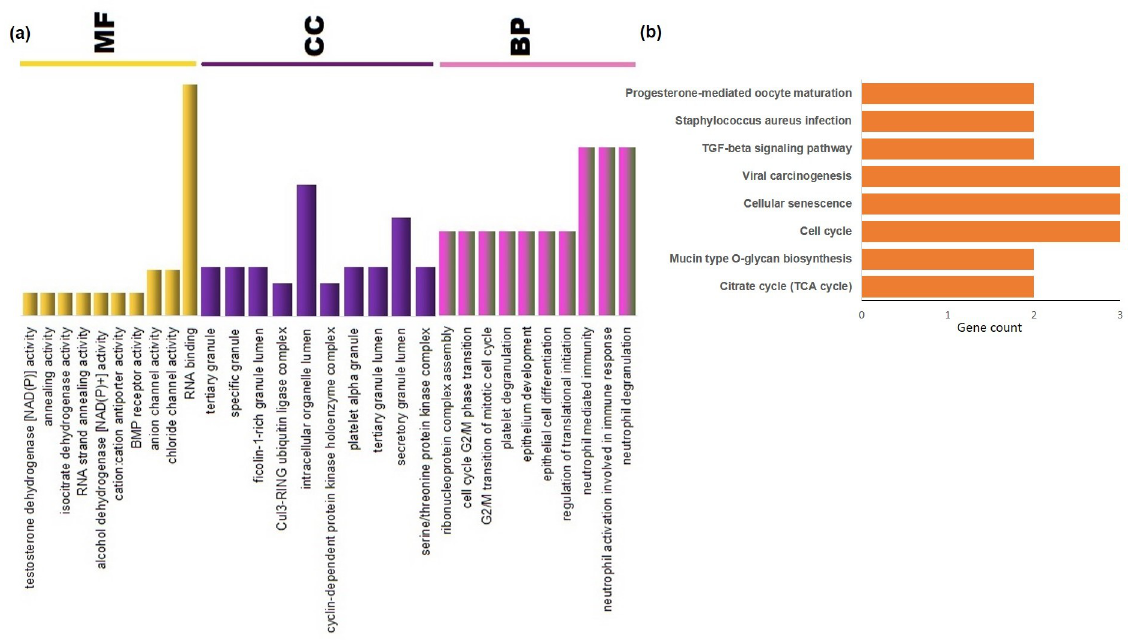
Fig 7. Enriched GO terms and biological pathways related to common genes (P-value < 0.05). (a) The top 10 GO terms for each category (Molecular Function (MF), Cellular Component (CC), and Biological Processes (BP)) are shown. The X-axis represents the enriched GO categories and the Y-axis shows the gene counts. (b) The top enriched KEGG pathways. The X-axis represents the enriched KEGG pathways and the Y-axis shows the no. of genes present in the respective pathway.